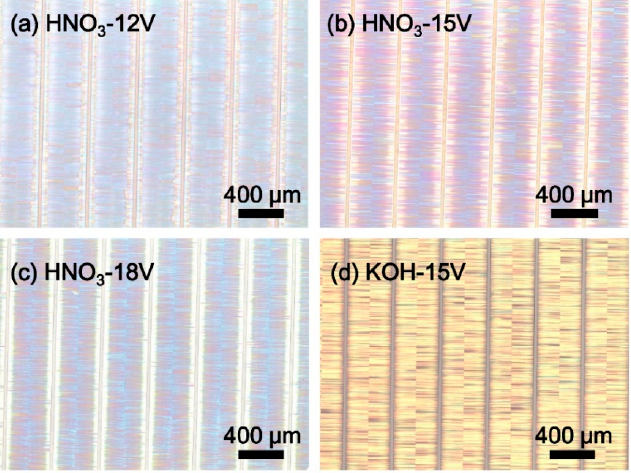
Figure 1. OM-images of porous AlGaN stacks etched in: ( a ) 15 M HNO 3 at 12 V; ( b ) 15 M HNO 3 at 15 V; ( c ) 15 M HNO 3 at 18 V; ( d ) 1 M KOH at 15 V.